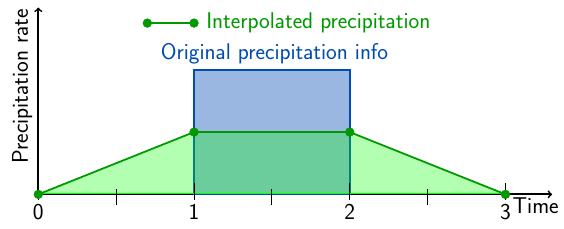
Figure 1. Illustration of the basic problem using an isolated precip- itation event lasting one time interval represented by the thick blue line. The amount of precipitation is given by the blue-shaded area. Simple discretisation would use the green circles as discrete grid- point representation and interpolate linearly in between, indicated by the green line and the green-shaded area. Note that supporting points for the interpolation are shifted by a half-time interval com- pared to the times when other meteorological fields are available.